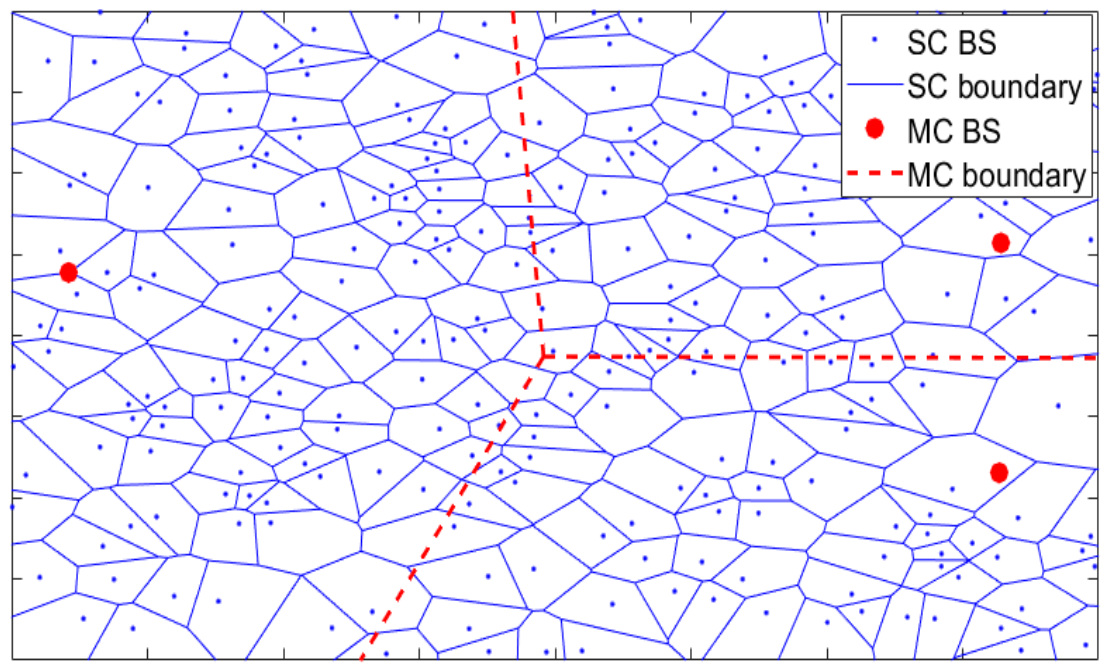
Figure 1. HetNet system model showing the densely deployed SCs.